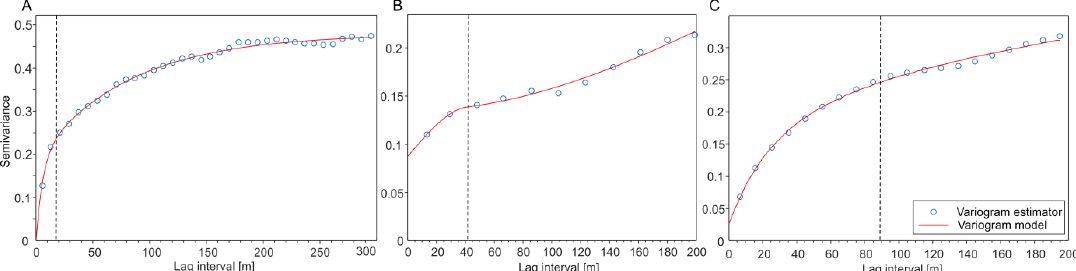
Figure 6. Empirical semivariograms and fitted models of ( A ) NDVI derived grassland biomass [dry matter weight, g m -2 ], ( B ) pH value, and ( C ) ECa[mS m -1 ]. Dashed vertical lines indicate the range of